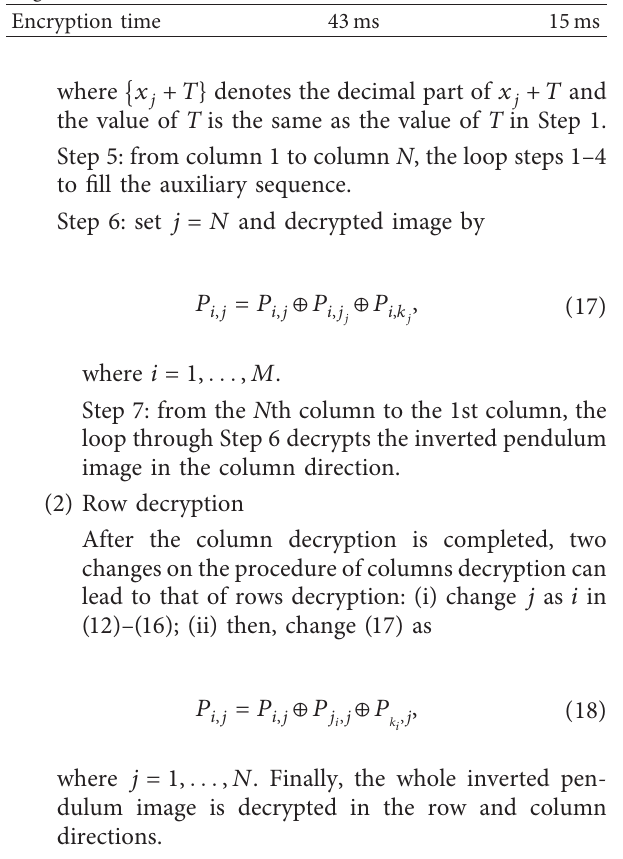
Table 1: Delay analysis of two different encryption algorithms.